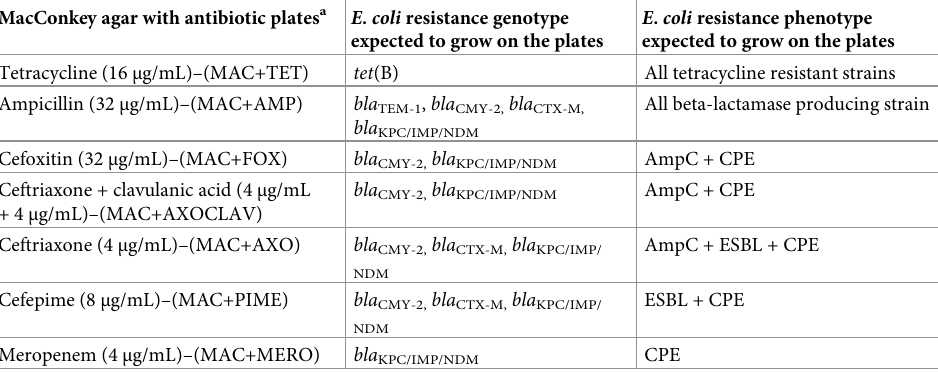
Table 1. Antibiotic supplemented media with presumed E . coli genotypes and phenotypes selectively grown on each type. MacConkey agar with antibiotic plates a E . coli resistance genotype E . coli resistance phenotype expected to grow on the plates expected to grow on the plates Tetracycline (16 μ g/mL)–(MAC+TET) tet (B) All tetracycline resistant strains Ampicillin (32 μ g/mL)–(MAC+AMP) All beta-lactamase producing strain Cefoxitin (32 μ